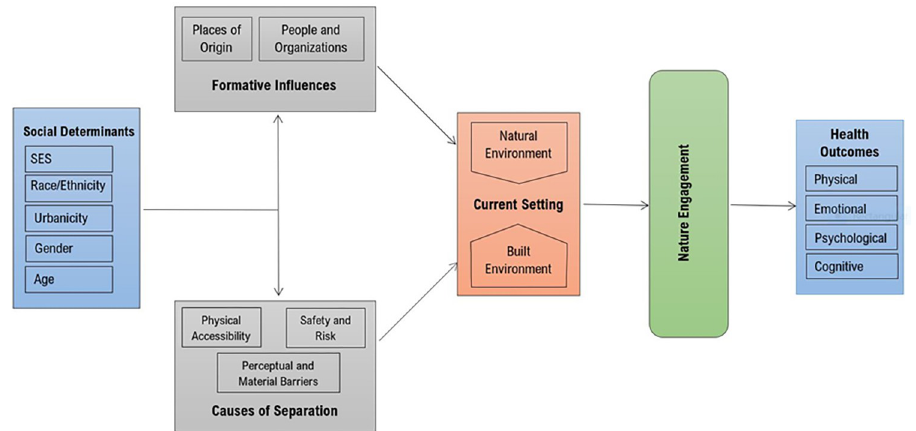
Fig 1. Conceptual framework describing a general model of exposure pathways to nature engagement identified through qualitative methods.